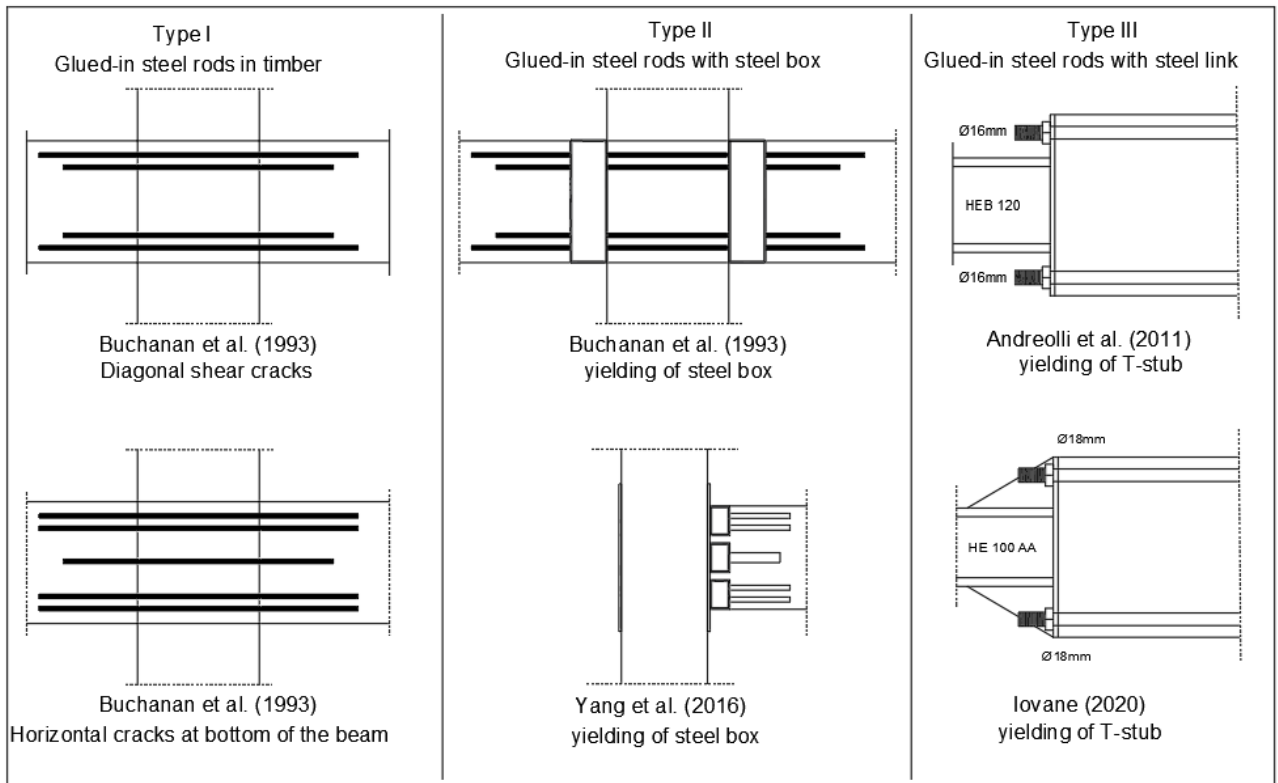
Figure 24. Geometric configurations and failure modes of glued-in rods ductile connections (adapted [43,54,55] from Refs.